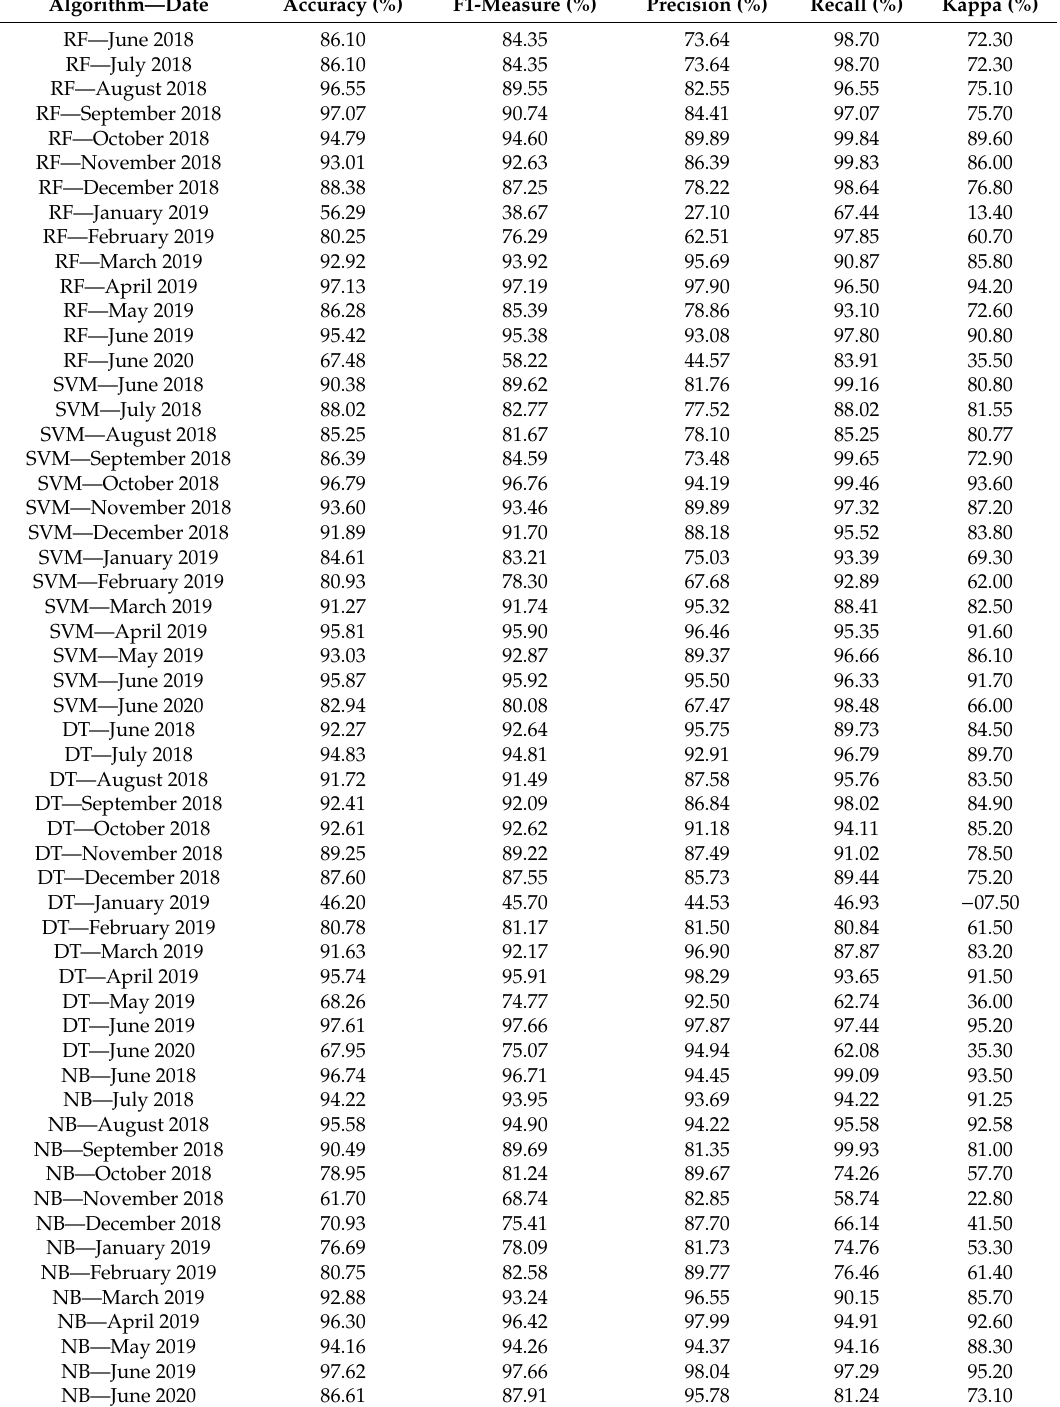
Table 4. Performance evaluation applying the trained model on all dates with di ff erent